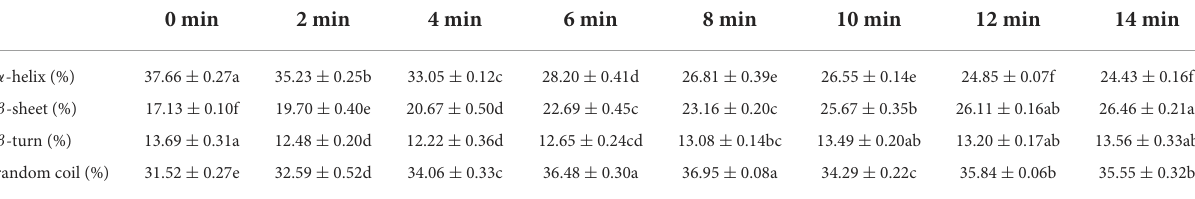
TABLE 3 Relative percentage of protein secondary structure of roasted Tan